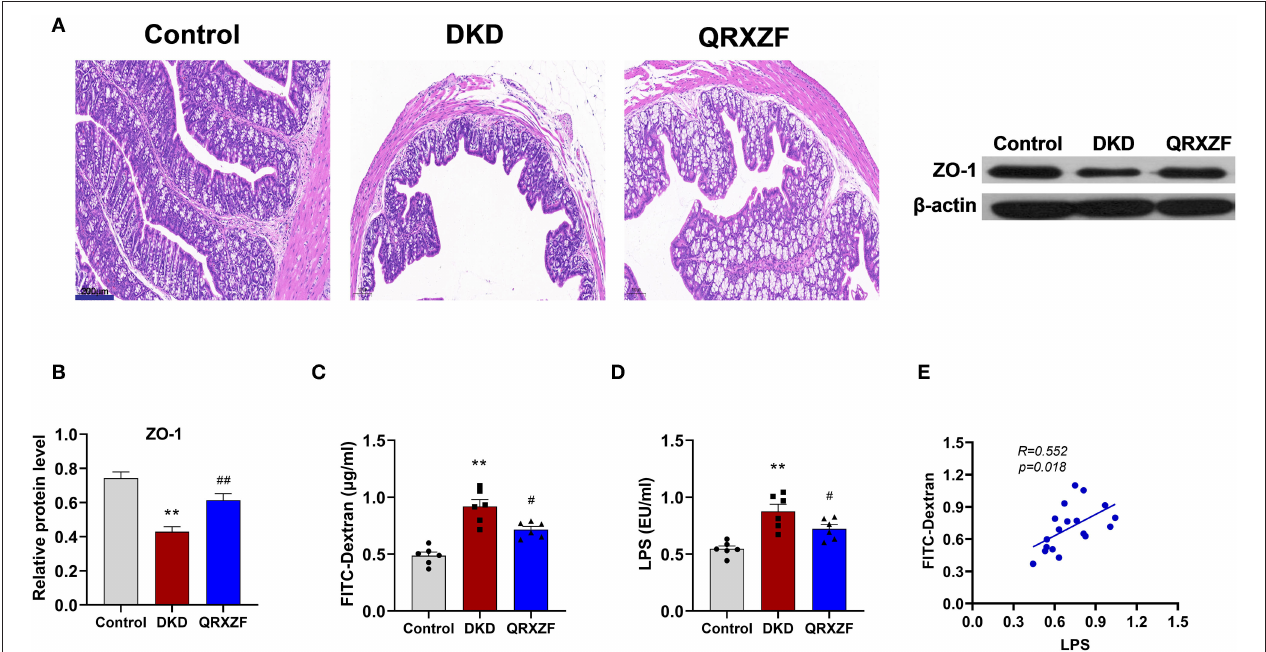
FIGURE 3 | QRXZF improved gut barrier. (A) HE stained at 100 × magnification; (B) Expression of ZO-1 evaluated by western blot analysis ( n = 3, means ± SEM); (C) serum FITC-dextran ( n = 6, means ± SEM.); (D) serum LPS; (E) Correlation analyses between serum LPS and FITC-dextran. * P < 0.05, ** P < 0.01 DKD group vs. the control group; # P < 0.05, ## P < 0.01 QRXZF group vs. the DKD